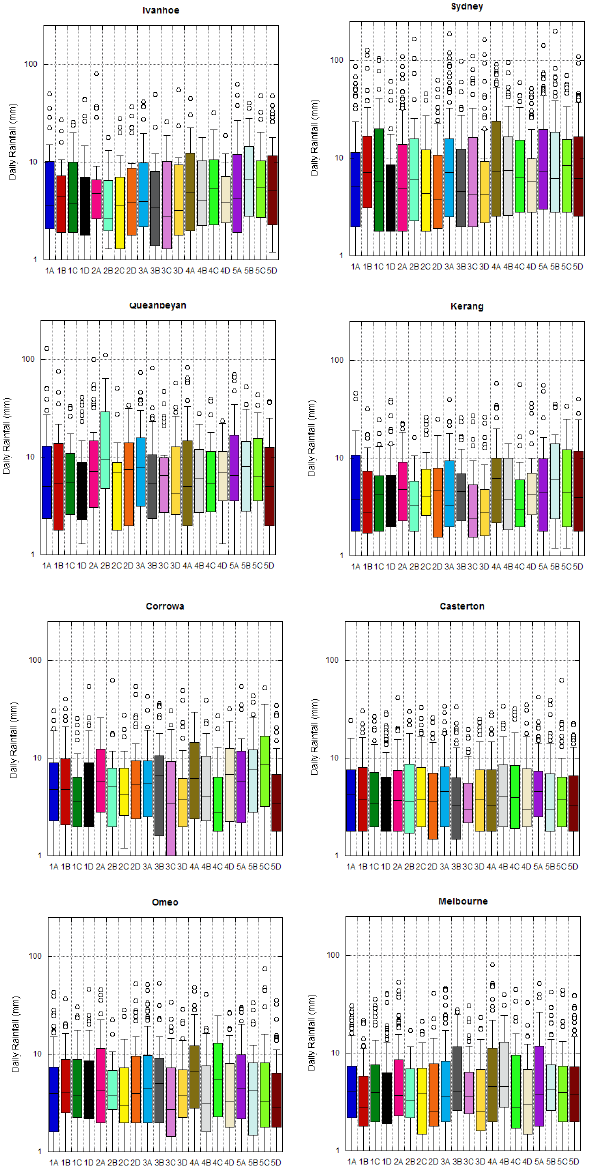
Figure 12. Daily rainfall distributions associated with each winter synoptic